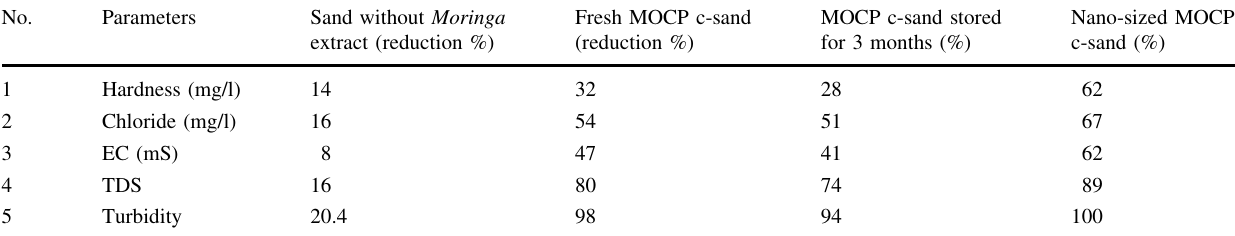
Table 1 Results of water quality parameters of filtered water using four types of sand layers (MOCP c-sand prepared with 4 g of Moringa seed powder) No.